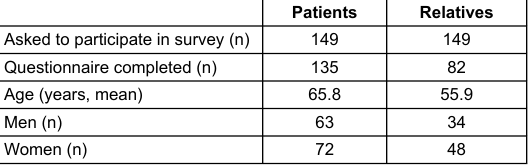
Table 1: Participation of multimorbid patients and first-degree relatives in